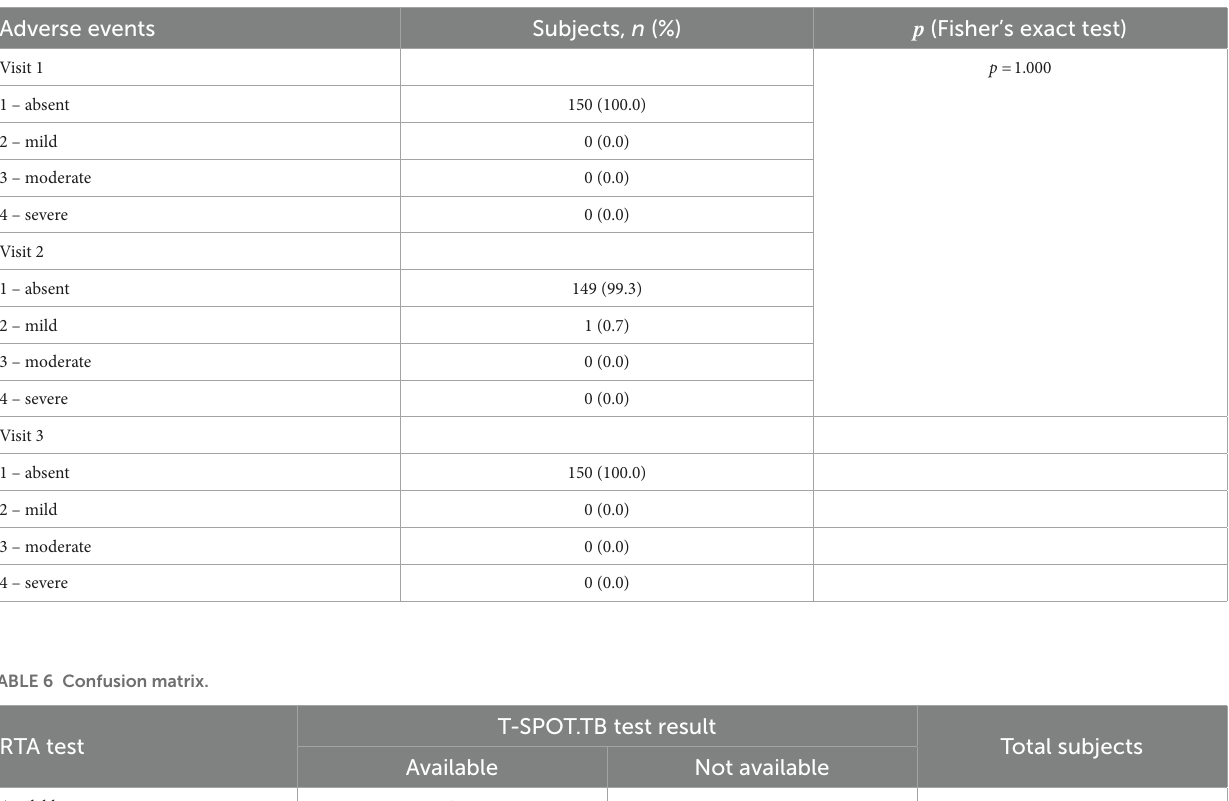
TABLE 5 Presence of adverse events.